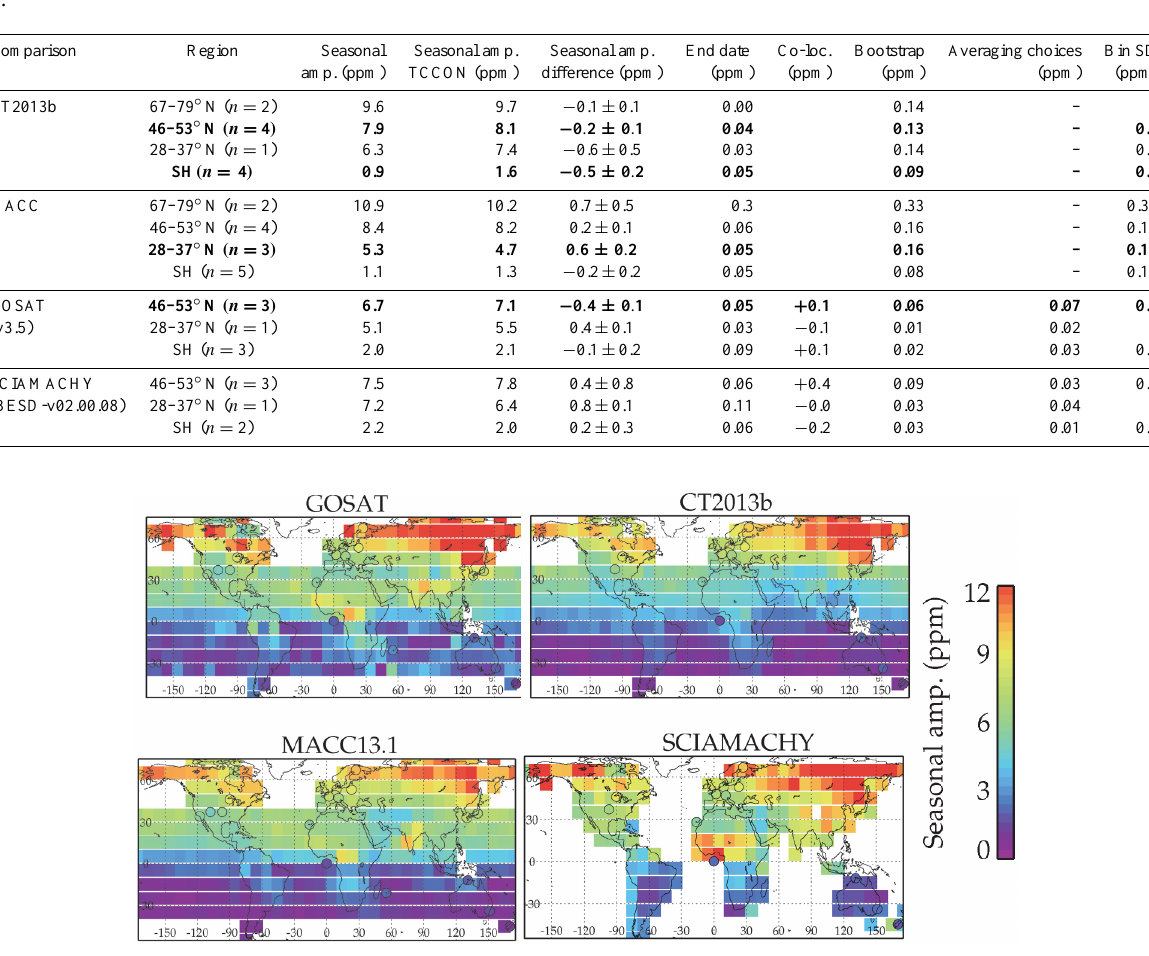
Figure 9. Seasonal cycle amplitude. The TCCON values are shown by the circles. The averaging is done over 10 × 10 ◦ bins every 5 ◦ . Comparisons vs. TCCON may be different than Table 4, since Table 4 has very close criteria for models and dynamic coincidence criteria for satellite data. The models are sampled at GOSAT